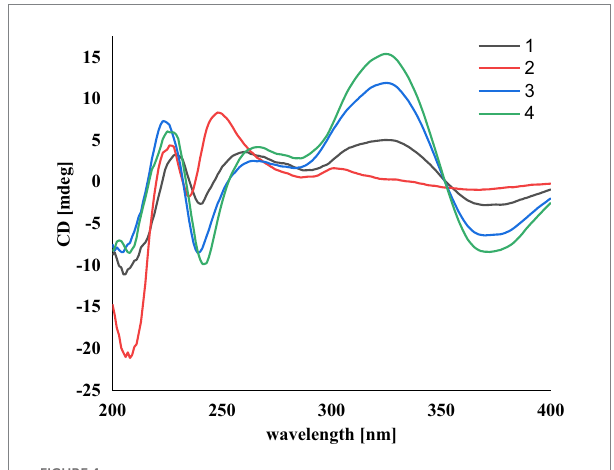
FIGURE 4 The experimental ECD spectra of compounds 1 - 4 .